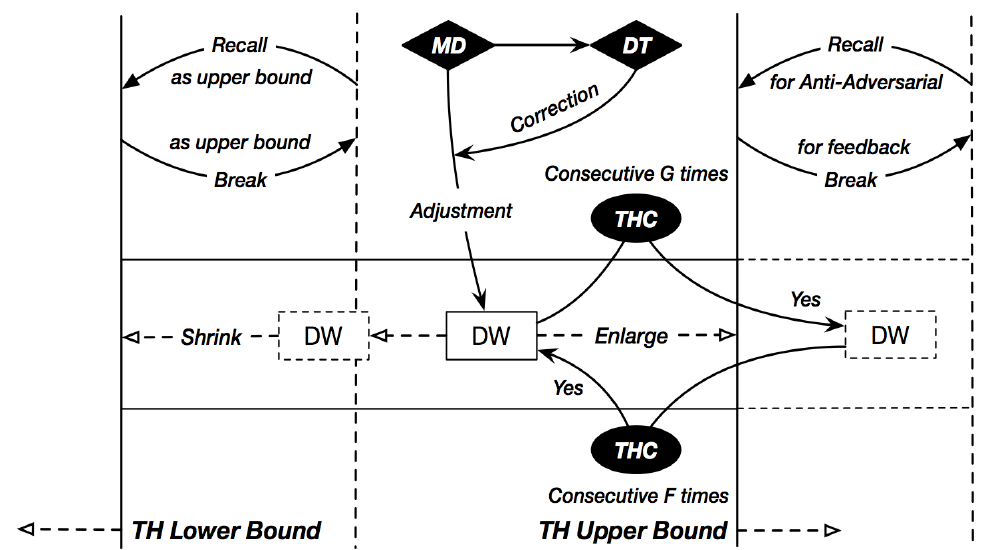
Figure 6. Overview logic chain of threshold.